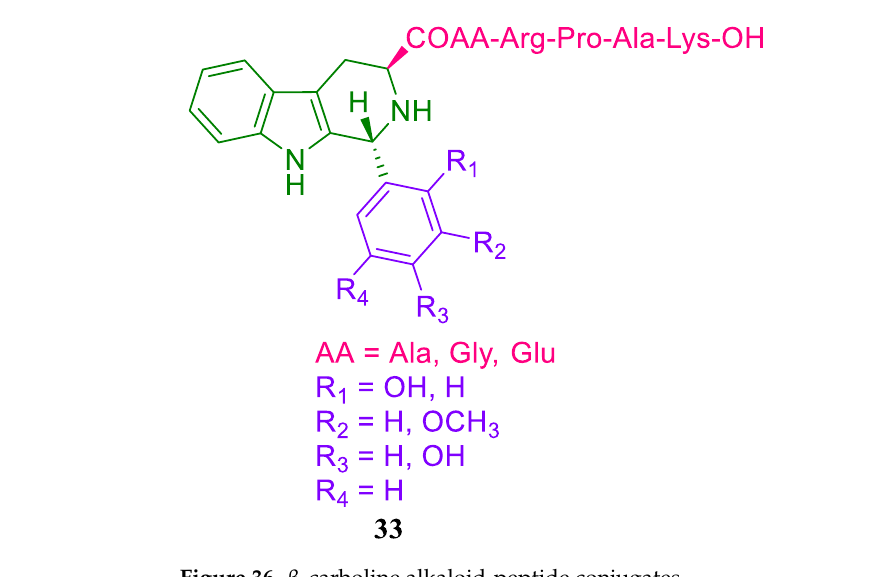
Figure 36. β -carboline alkaloid-peptide conjugates.